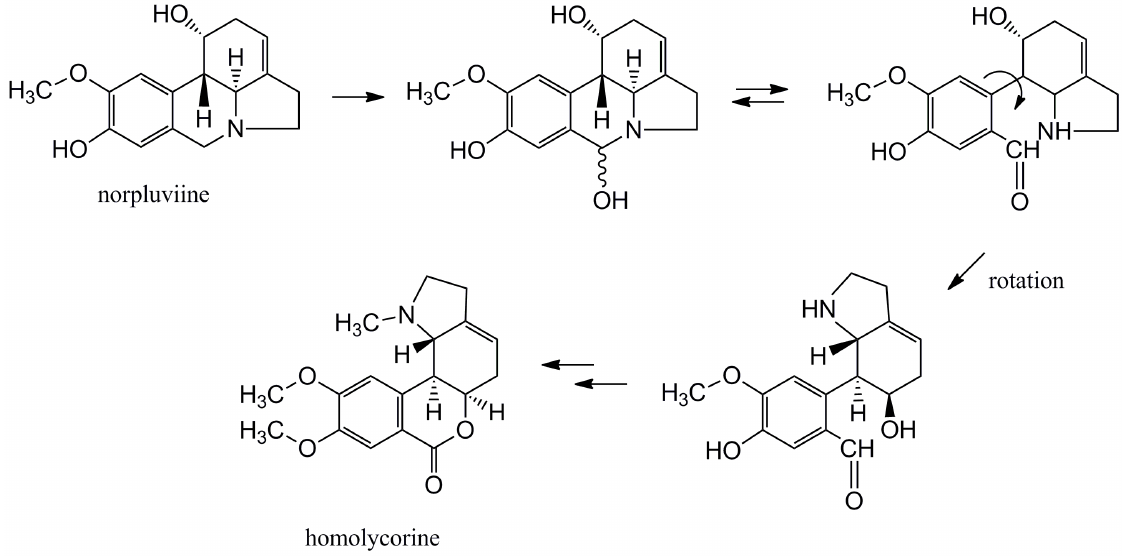
Figure 5. Formation of homolycorine from norpluviine following ring opening and intramolecular